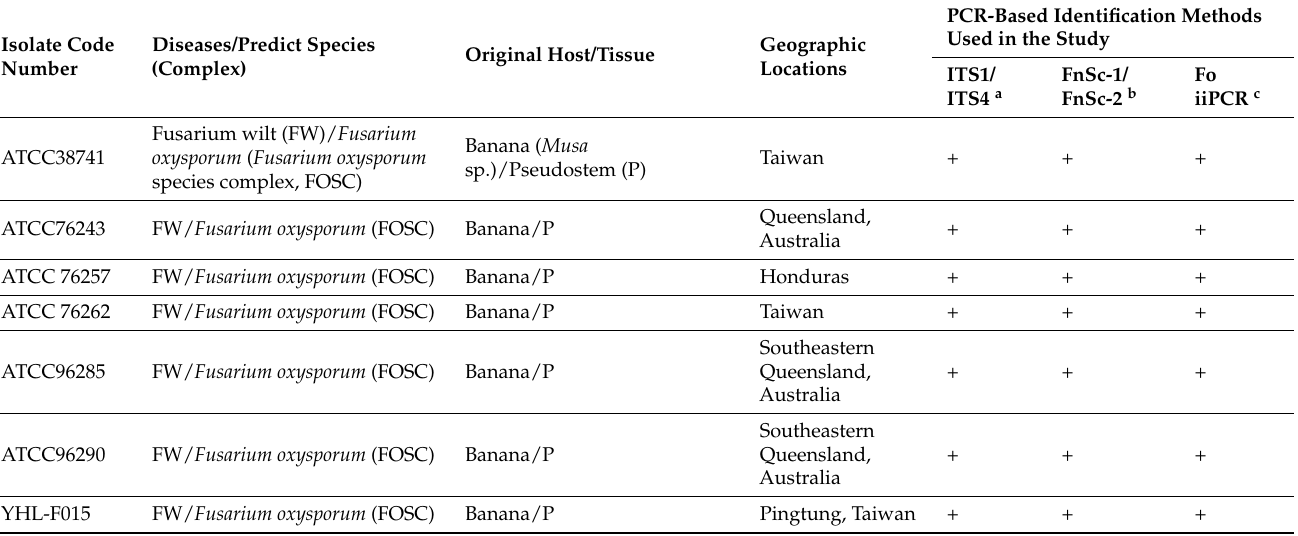
Table 1. Fungal isolates of the phytopathogens and the results of their detection with the molecular detection methods used in this